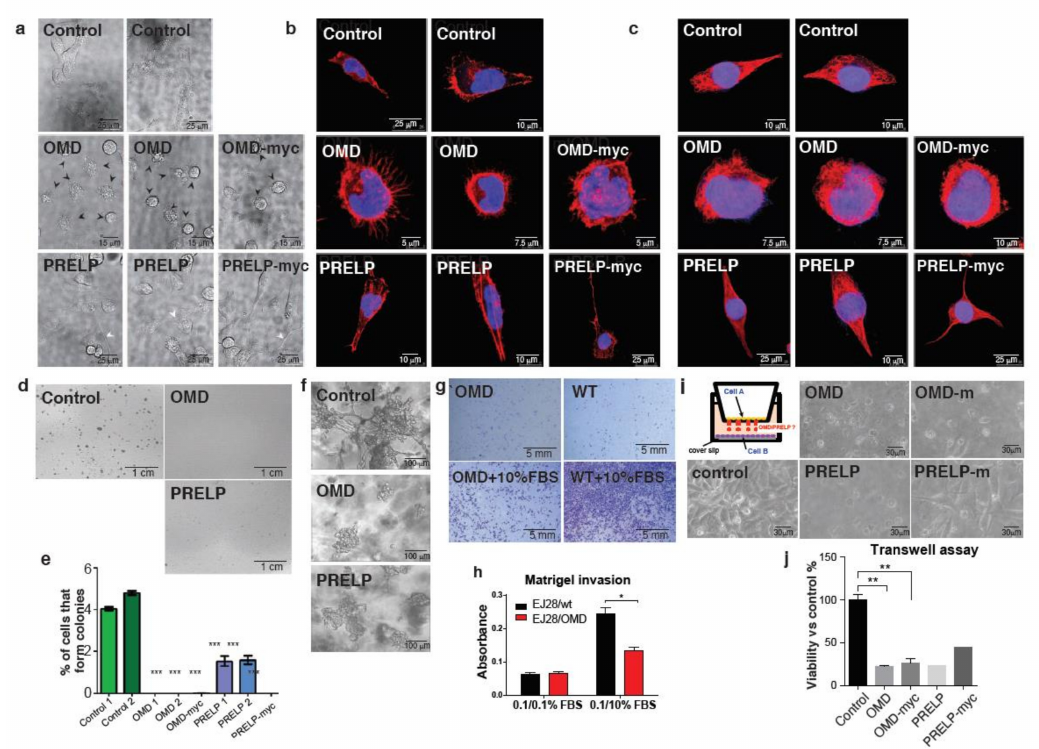
Figure 3. Effect of OMD or PRELP overexpression in bladder cancer cell lines. ( a ) Cell morphology of EJ28 bladder cancer cells transfected with OMD, OMD-myc, PRELP, or PRELP-myc constructs, observed by differential interference contrast (DIC) microscope. Round cells are indicated as arrowheads. ( b ) Phalloidin staining of the transfected EJ28 cells. Phalloidin (red) and DAPI (blue). Pin-like structures of OMD overexpressing cells are phalloidin-positive. PRELP overexpression results in clear long actin fiber formation. ( c ) Anti-tubulin antibody staining. Tubulin (red) and 4 (cid:48) ,6-diamidlino-2-phenylindole (DAPI) (blue). ( d,e ) Anchorage-independent growth using the soft agar. Photos of control, OMD, and PRELP overexpressing colonies formed in the top agar layer ( d ). Quantification of the cell percentage that formed colonies ( e ). ( f ) Cell growth in the Matrigel. ( g , h ) Cell migration and invasion assay using the Boyden chamber. Photos of cells that invaded to the bottom side of membrane after the addition of fetal bovine serum (FBS) as a chemoattractant ( g ). Quantification of cell migration / invasion in ( g , h ). ( i , j ) Transwell co-culture assay to evaluate the effect of secreted OMD / PRELP on non-contacting cells. Schematic drawing of the assay system and photos of EJ28 cells cultured at the button chambers ( i ). Quantification of viable cell density in the bottom well by trypan blue staining ( j ). *, **, *** indicate p < 0.01, p < 0.005, p < 0.001,